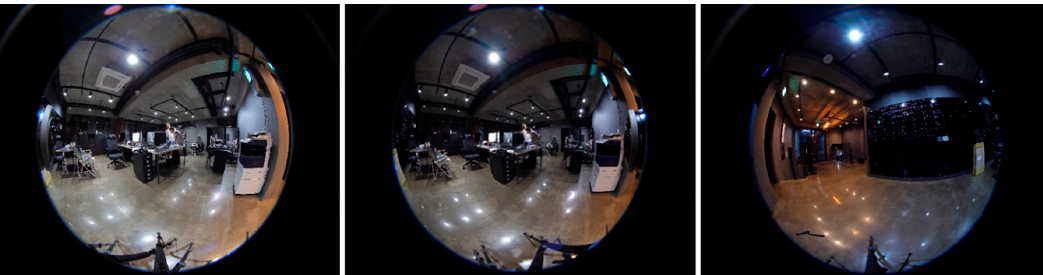
Figure 9. Image from the left-front camera ( left ), image from right-front camera ( center ), image from rear camera ( right ).